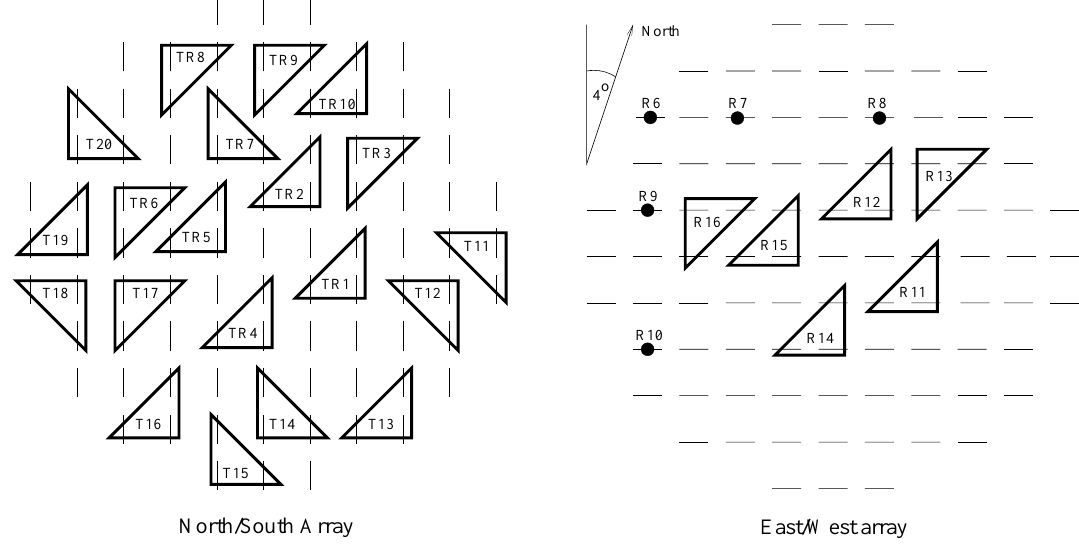
Fig. 3. Antenna configuration employed for initial routine observations using the Buckland Park MF radar. Each vertical line on the north/south array (left) represents a single north–south aligned antenna, while each horizontal line on the east/west array (right) represents a single east/west aligned antenna. The triangles denote the antennas used for observations, and the appropriate transmit channel. Antenna groups denoted TR i and T i were connected to transmitter i . Antenna groups denoted TR i were connected to receiver i via T/R switch i . Antenna groups denoted R i were connected directly to receiver i . The filled circles denoted R i were connected to receiver i for meteor observations from March 2000.